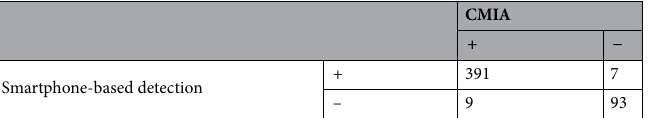
Table 1. The comparison of obtained results between the smartphone-based immunosensor and CMIA method. + : Positive result, − : Negative result.